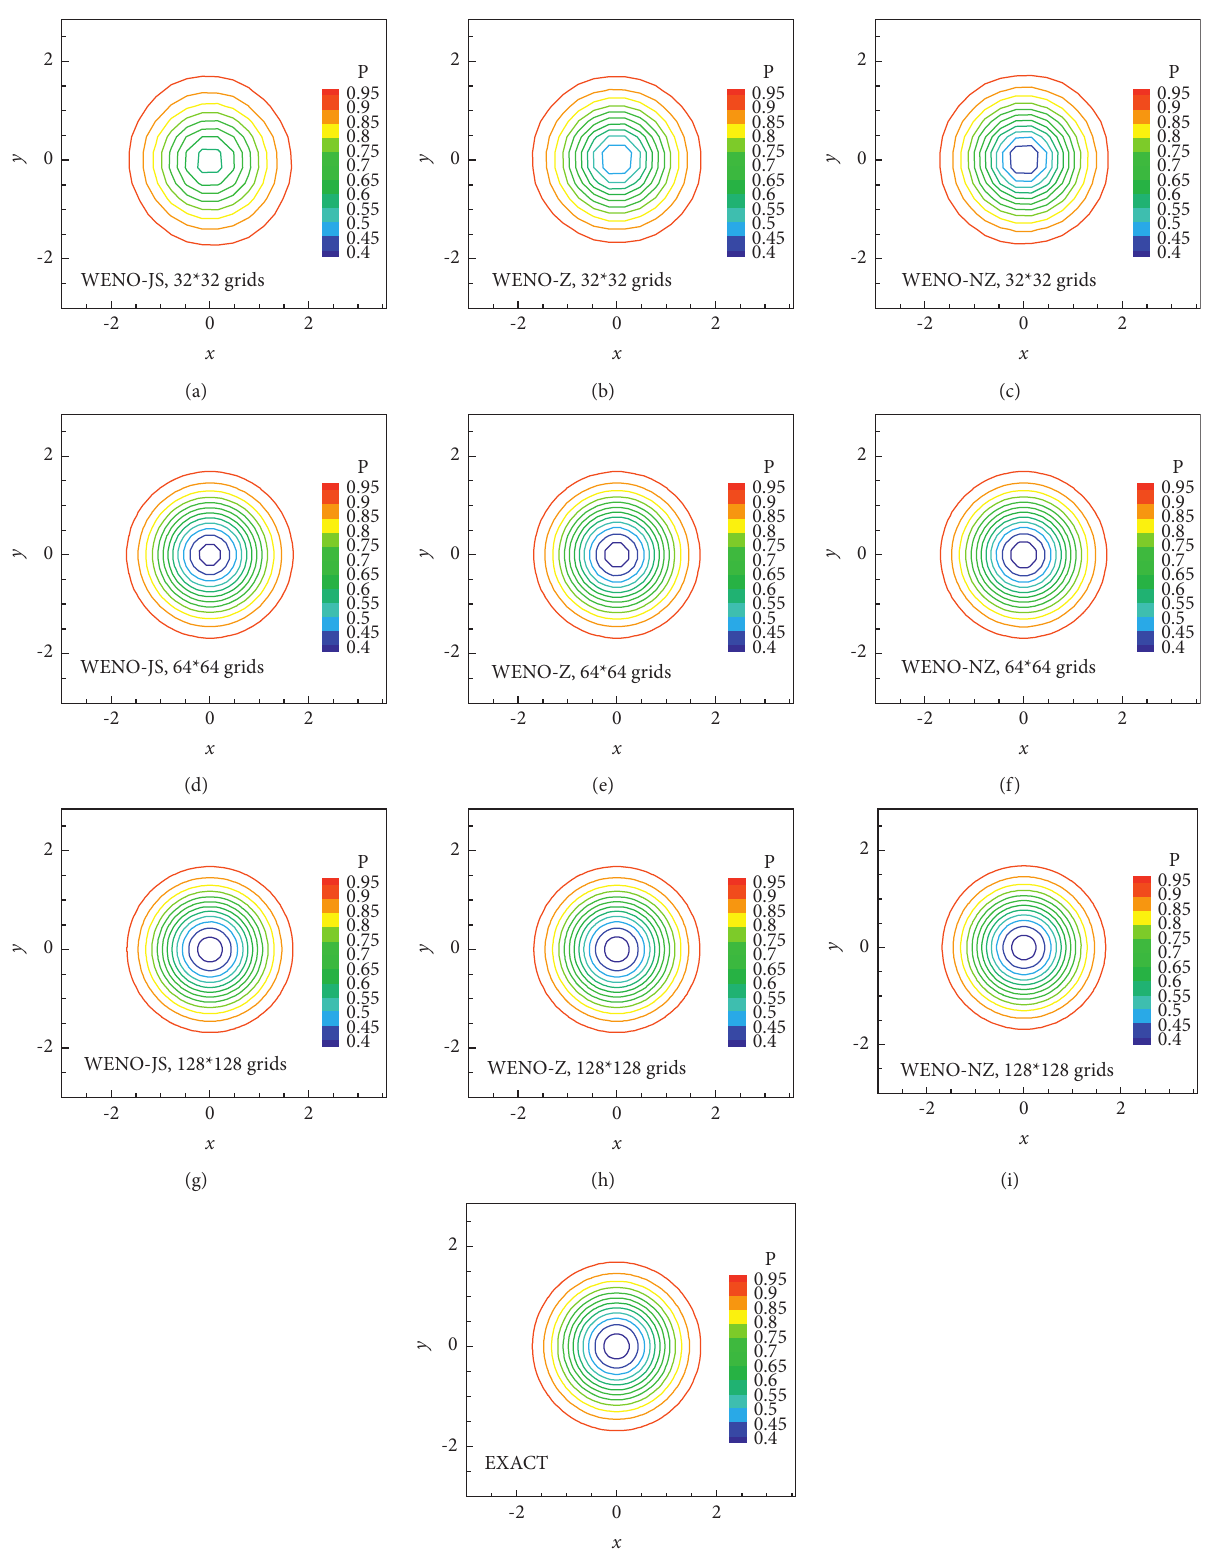
Figure 6: Pressure contours for isentropic vortex convection after two